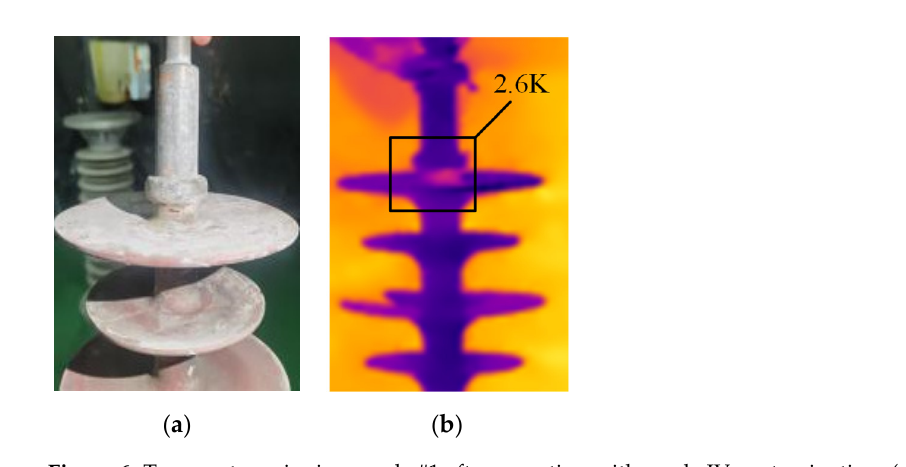
Figure 6. Temperature rise in sample #1 after recoating with grade IV contamination: ( a ) contamination recoating; ( b ) temperature rise image.